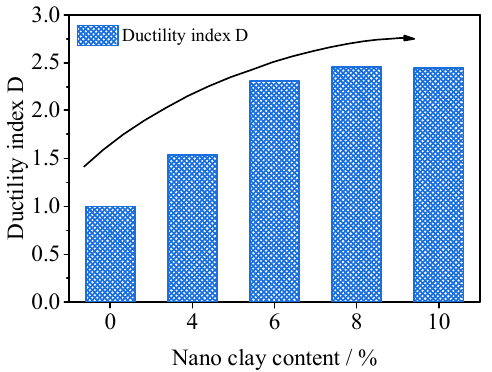
Figure 4. Relationship between nano-clay content and ductility index